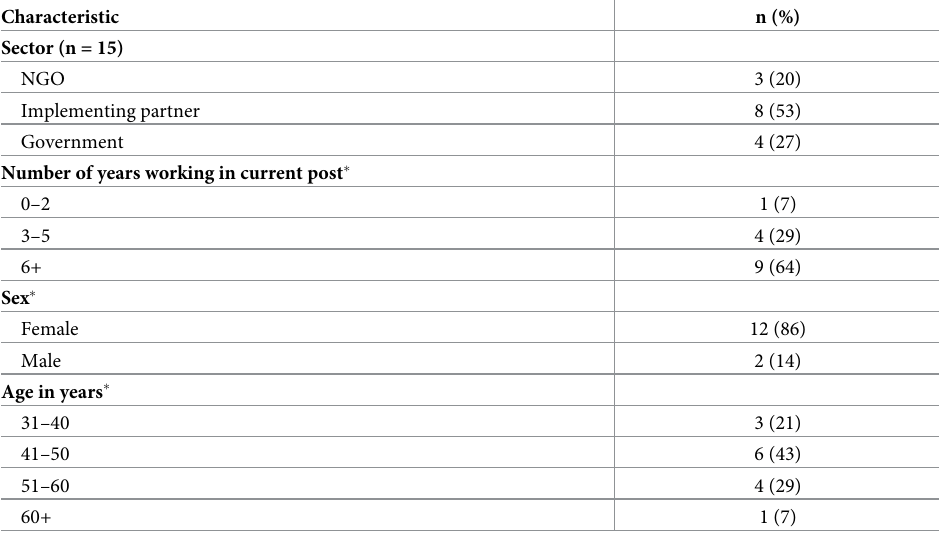
� n = 14 as one key informant did not provide demographic